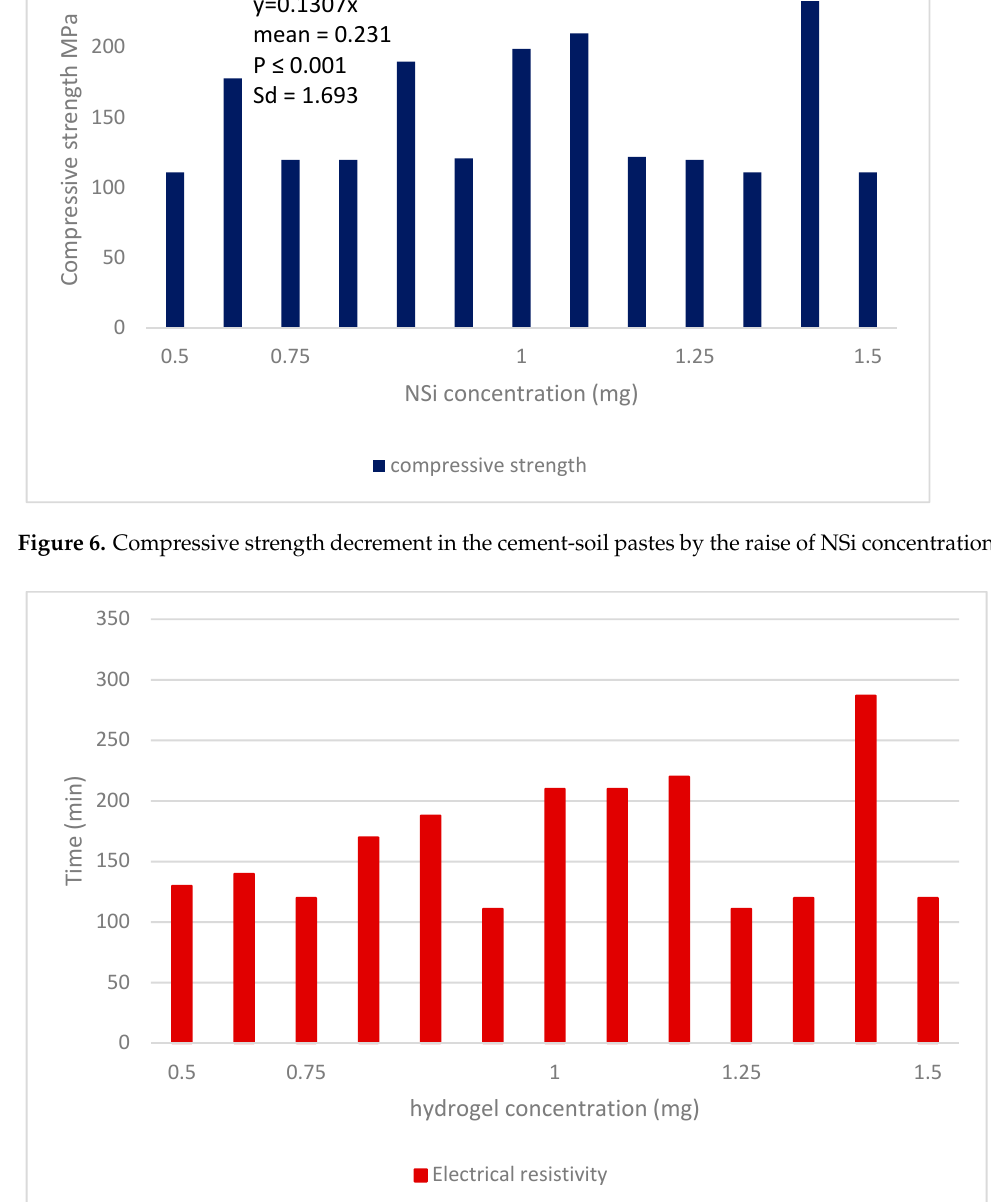
Figure 7. Electrical resistivity in the cement-soil pastes by the increase of NSi concentration.